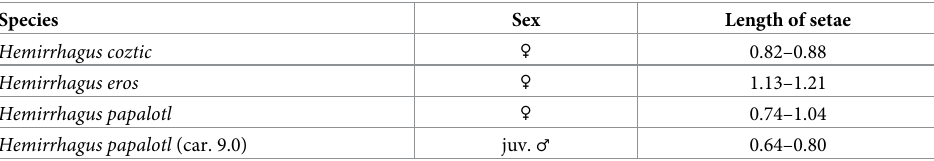
Table 13. Length ranges of type VI setae. juv. = juvenile specimen. car. = length of